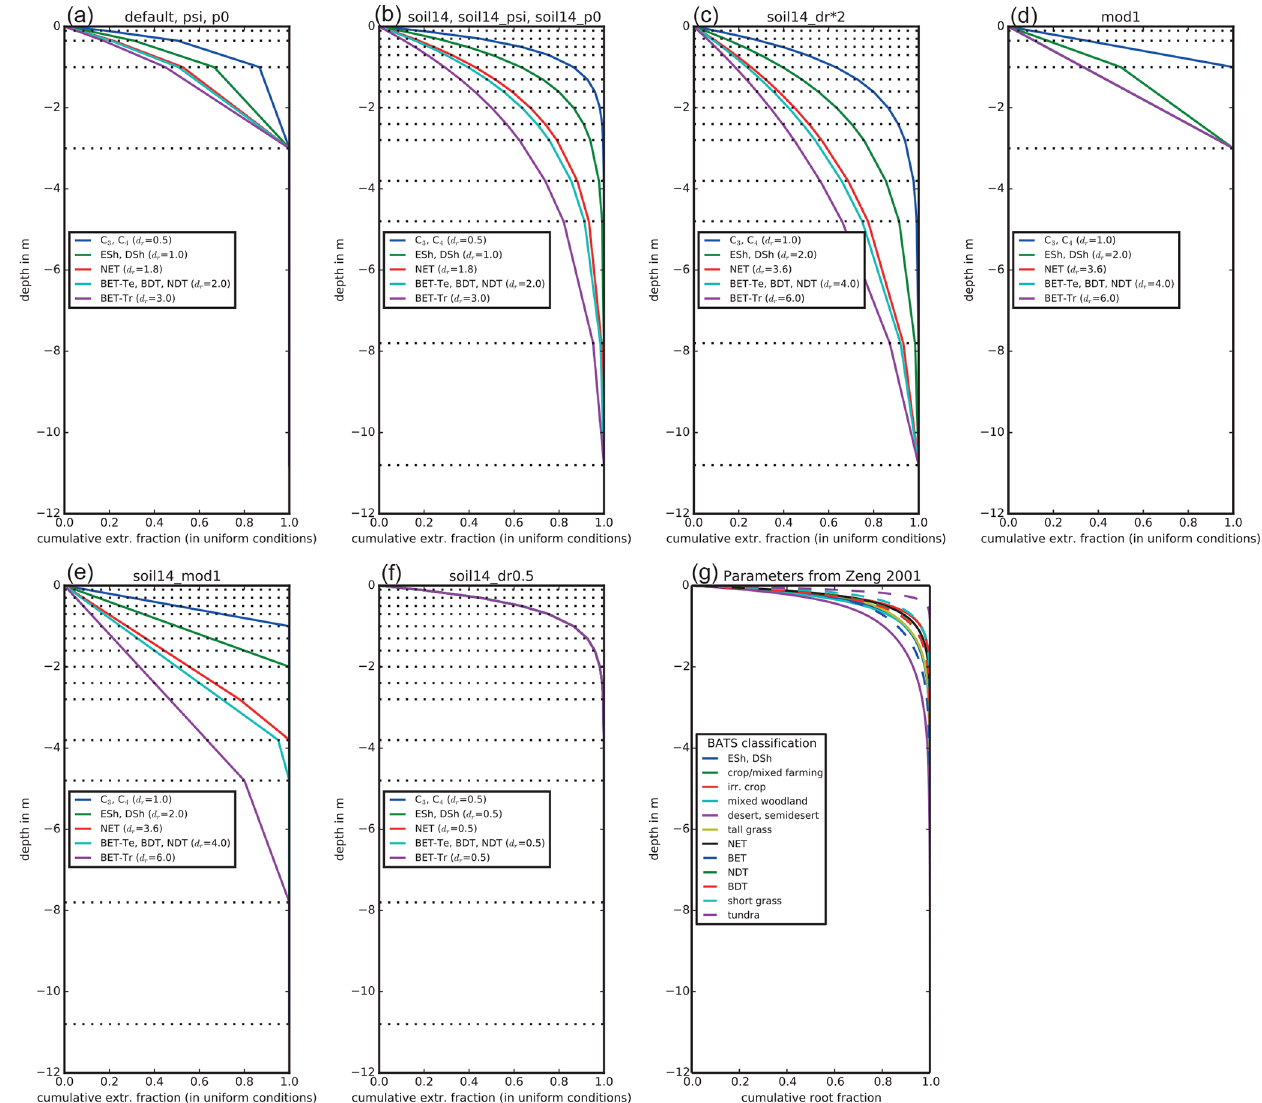
Figure 2. Effective root water extraction profiles for JULES. The parameter d r is the e -folding depth for weighing root water extraction and soil moisture stress. The plant functional types (PFTs) are C 3 and C 4 grasses, evergreen and deciduous shrubs (ESh, DSh), needleleaf evergreen trees (NET), temperate broadleaf evergreen trees (BET-Te), broadleaf deciduous trees (BDT), needleleaf deciduous trees (NDT), and tropical broadleaf evergreen trees (BET-Tr). The horizontal dotted lines show the bottom depth of each layer. Profiles for the experiments in this study are shown: with the default 3m deep, 4-layer soil (a) ; with an updated 10.8m deep, 14-layer soil (b) ; with the 10.8m deep soil and doubled d r (c) ; with water extraction weighted by layer thickness and 3m deep soils (d) ; with water extraction weighted by layer thickness and 10.8m deep soils (e) ; and with all PFTs having d r = 0.5 and the 10.8m deep soil (f) . For comparison, panel (g) shows root fractions from Zeng (2001), where distributions were calculated based on available measurements of root